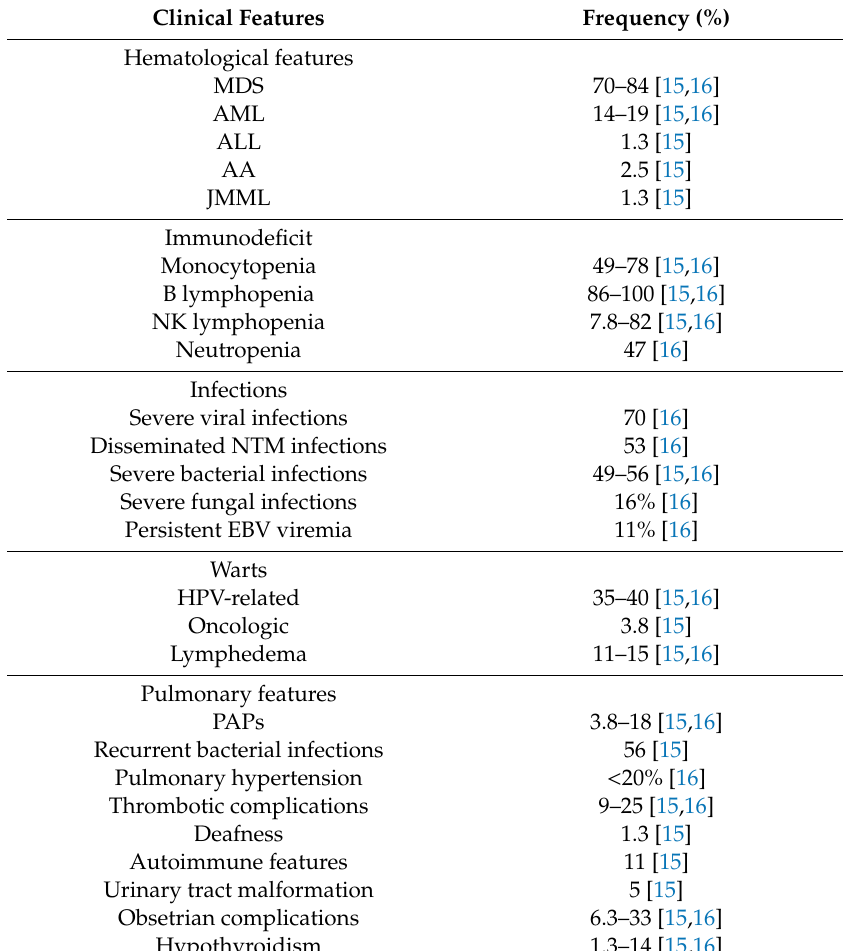
Table 1. Clinical features of GATA2